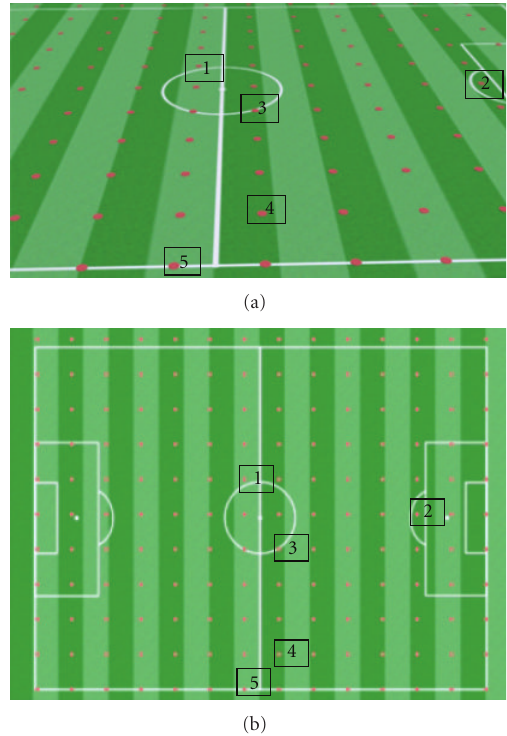
Figure 10: A part of TG-Creator interface. Numbers and black rectangles refer to some of equivalent points in both an initial frame in the left and real model in the